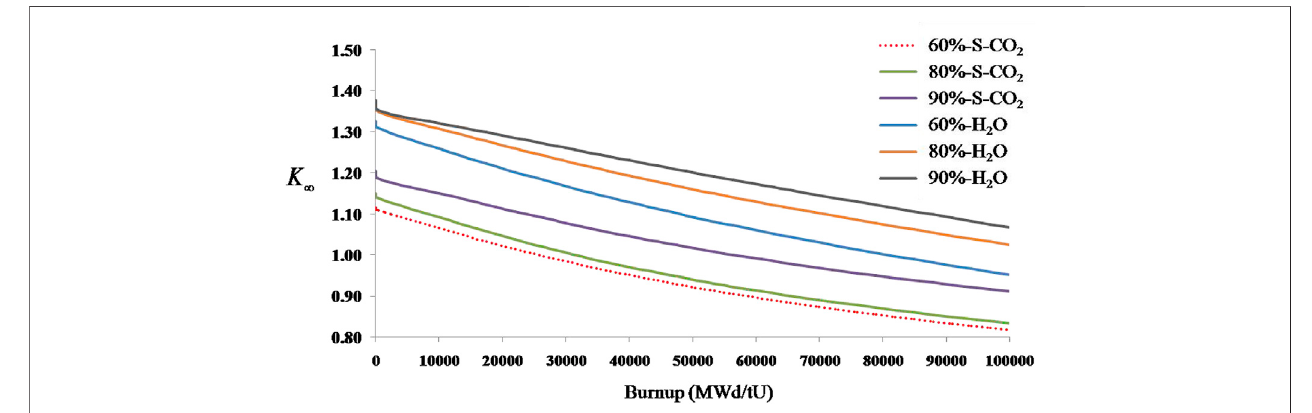
FIGURE 4 | K ∞ by different SiC matrix share versus burn up.